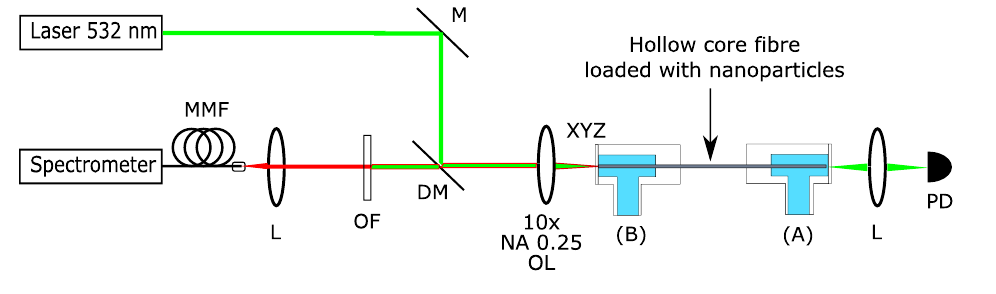
Figure 3. Optical setup for measurement of nanoparticle solution loaded into HC-PCF. Nanoparticle samples were loaded in enclosure (A) and filled the fiber by capillary action towards enclosure (B). Laser light travelled through the fiber from (B) to (A), with back-scattered Raman light travelling in the opposite direction. L: lens; OF: optical filter; M: mirror; DM: dichroic mirror; OL: objective lens; XYZ: translation stage; PD: photodetector; MMF: multimode optical